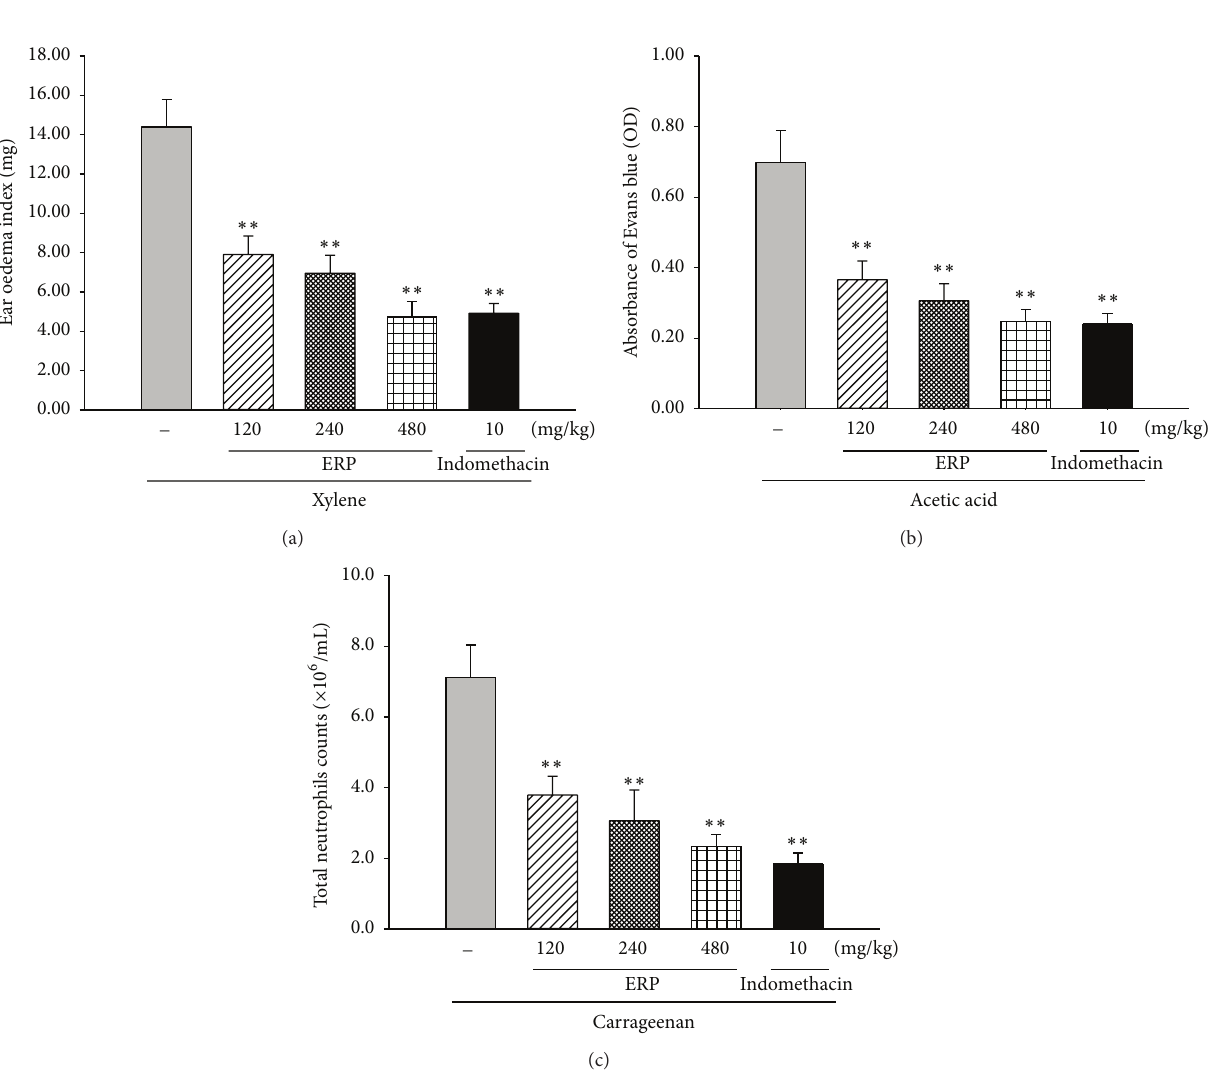
edema was approximate to that of indomethacin group (for both, 𝑃 < 0.01 versus xylene-control